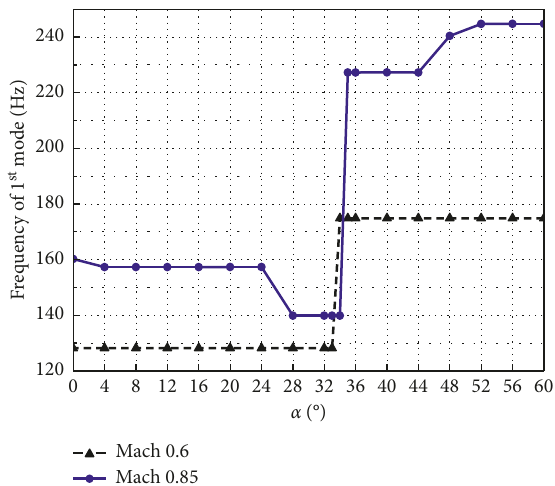
Figure 11: Comparison of the first mode frequencies of tonal noise at K